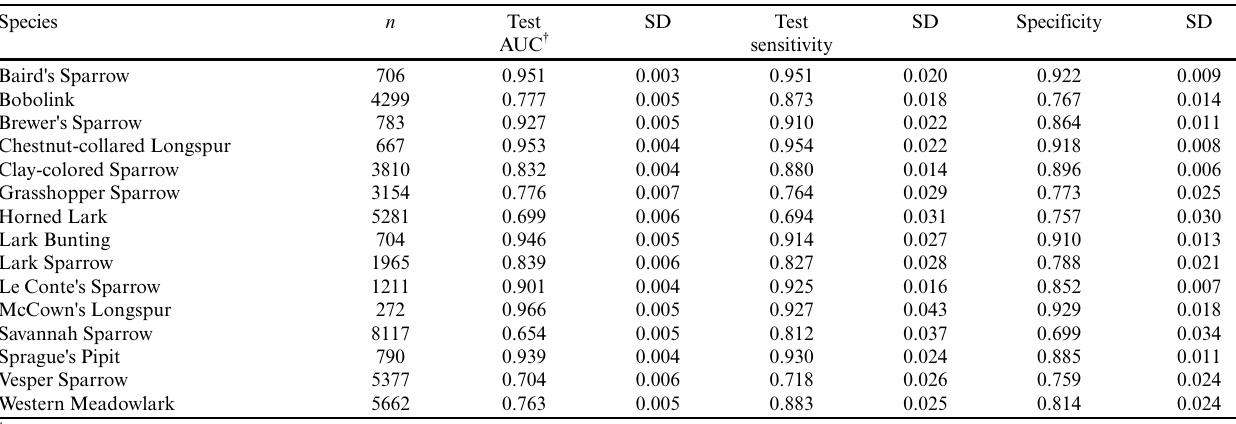
Table 3 . Predictive performance of average MaxEnt models for each grassland songbird species. Average models are based on 50 bootstrapped replicates with a 70%–30% training-testing split of the occupied 4 x 4 km grid cells ( n ) in each replicate. Sensitivity and specificity were evaluated using the threshold that maximized the sum of sensitivity and specificity for each species. Sensitivity was evaluated using the threshold identified from the training data set applied to the test data set. Specificity was evaluated using the same threshold, applied to all unoccupied background